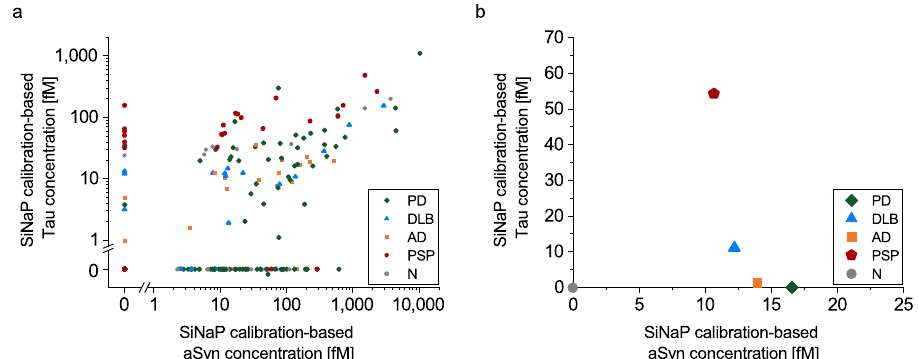
Fig. 11 Correlation of aSyn and Tau aggregate concentration. a aSyn and Tau aggregate concentrations measured by sFIDA show a highly signi fi cant correlation across all samples tested (Pearson coef fi cient of correlation r = 0.81, p = 3.8*10 − 57 ) as well as for each individual cohort. Correlation of the median values for the disease groups is plotted in b